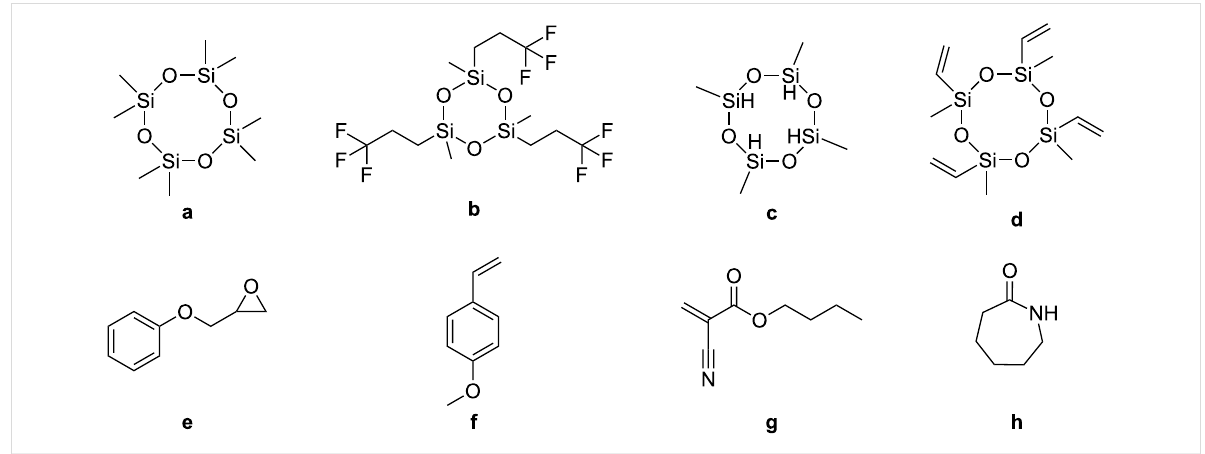
Figure 4: Monomers used in ionic miniemulsion polymerization. a: octamethylcyclotetrasiloxane [9,74], b: 1,3,5- tris(trifluoropropylmethyl)cyclotrisiloxane [75], c: 2,4,6,8-tetramethylcyclotetrasiloxane [76], d: tetramethyltetravinylcyclotetrasiloxane [77], e: phenyl glycidyl ether [78], f: p -methoxystyrene [79-81], g: n -butyl cyanoacrylate [82-90], h: ε -caprolactam